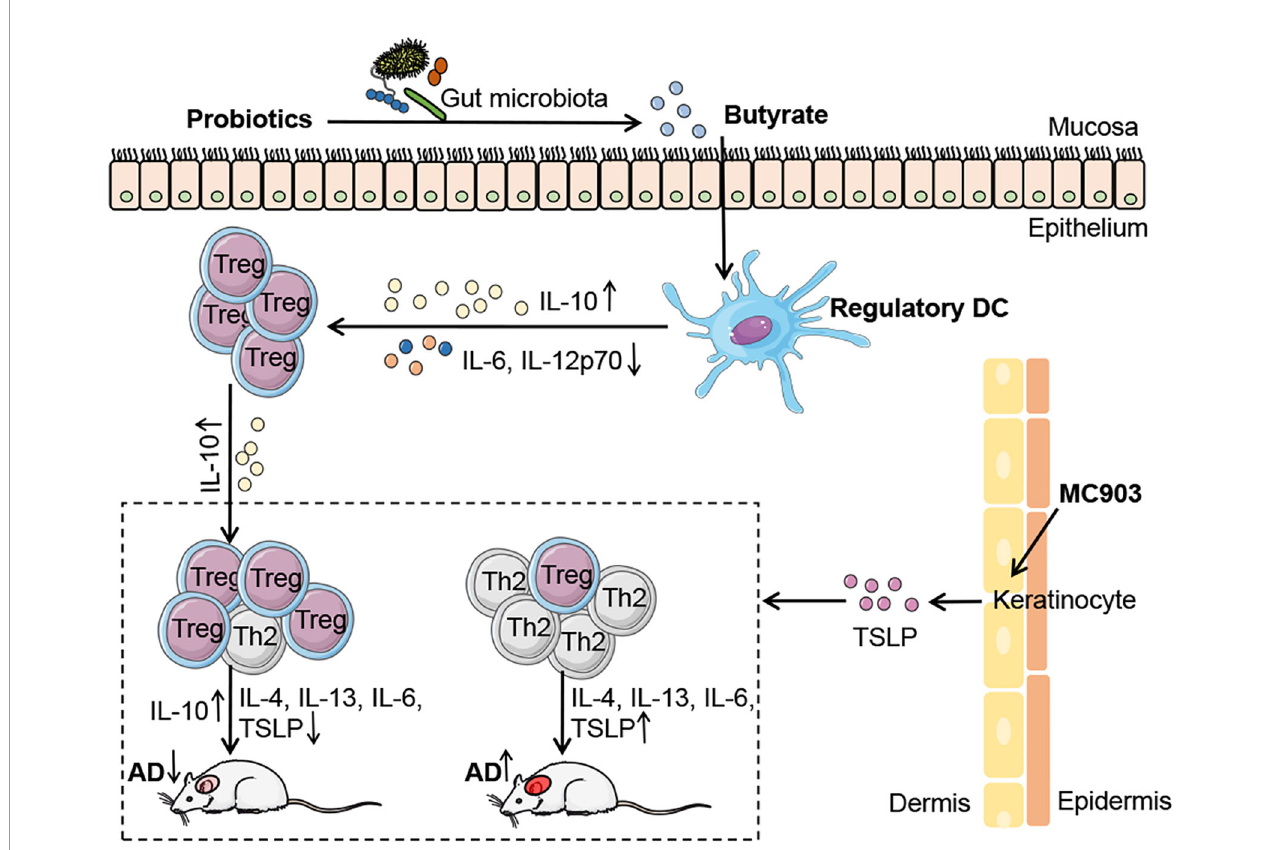
FIGURE 6 | | Schematic illustrating the underlying mechanism of probiotics in AD. IW5 administration restores the diversity of the gut microbiota in AD mouse models and increases the production of SCFAs (acetate, propionate, and butyrate). Butyrate induces DCregs production, which results in Tregs differentiation and amelioration of AD